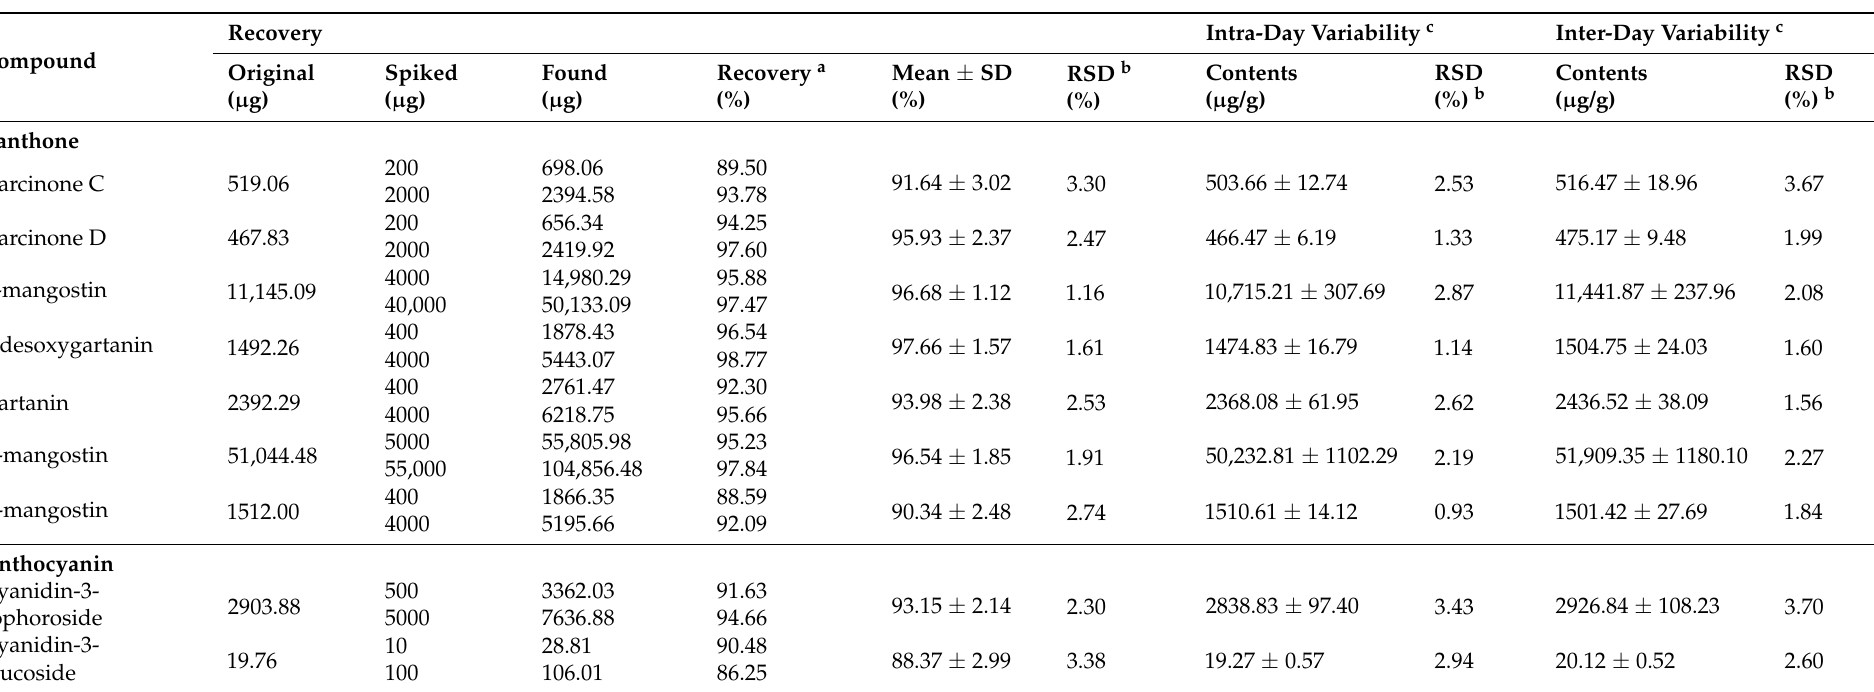
Table 2. Quality control data including recovery, intra-day variability and inter-variability of xanthone and anthocyanin in mangosteen peel as determined by